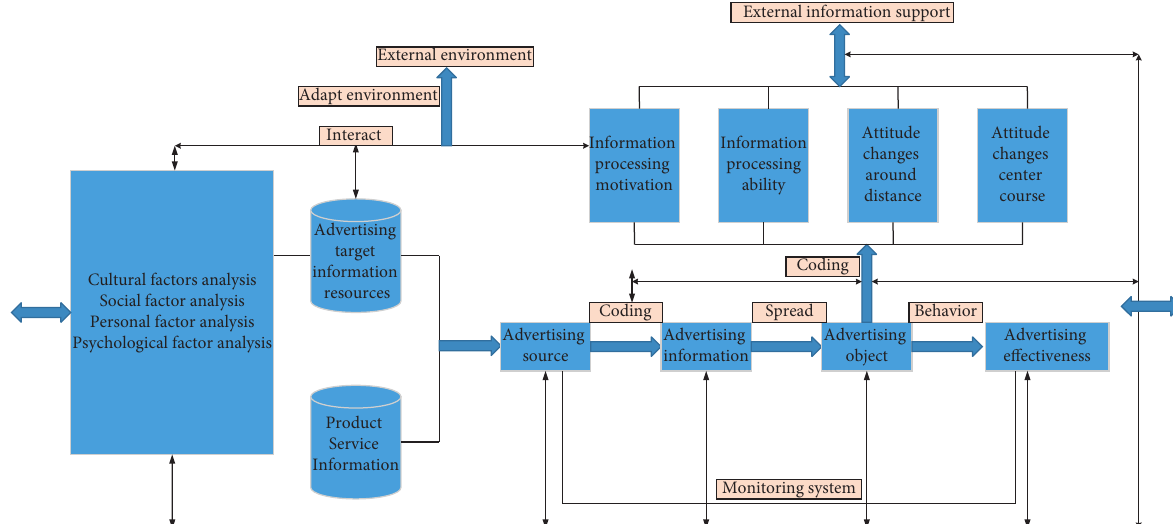
Figure 1: Dynamic adaptation of advertising information